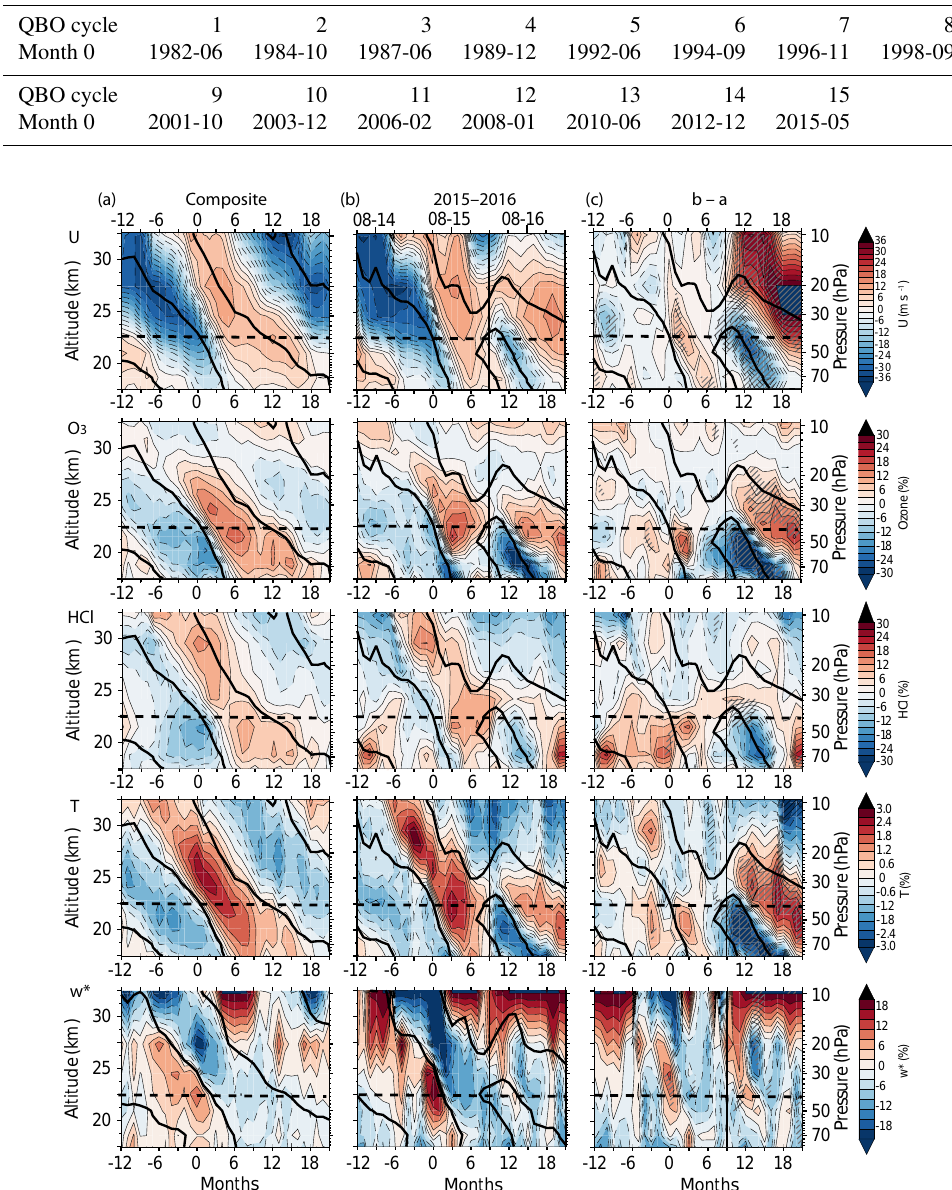
Figure 1. The rows show the MERRA-2 zonal mean zonal wind component, u (ms − 1 ), deseasonalized MLS O 3 , HCl, temperature ( T ), and vertical component of the MERRA-2 residual circulation ( w ∗ ), as a function of time and pressure (in percent change from long-term monthly averages), averaged over 5 ◦ S–5 ◦ N. Column (a) shows the composite of the easterly-to-westerly shear transitions based on four shear transitions at 40hPa. Column (b) shows the 2015–2016 QBO cycle, which includes the data from May 2014 to February 2017, with month 0 in May 2015. Column (c) shows the difference between the 2015–2016 event and the climatology (b–a) with hatching indicating regions with absolute difference (b–a) larger than 2 standard deviations The thick black contours denote zero wind shear. The horizontal dashed line indicates the 40hPa level, while the vertical line indicates February